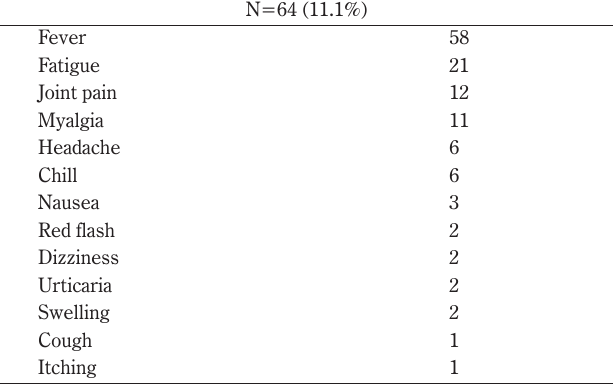
Table 3 Self-reported symptoms of adverse reaction to second dose of mRNA COVID-19 vaccines N=64